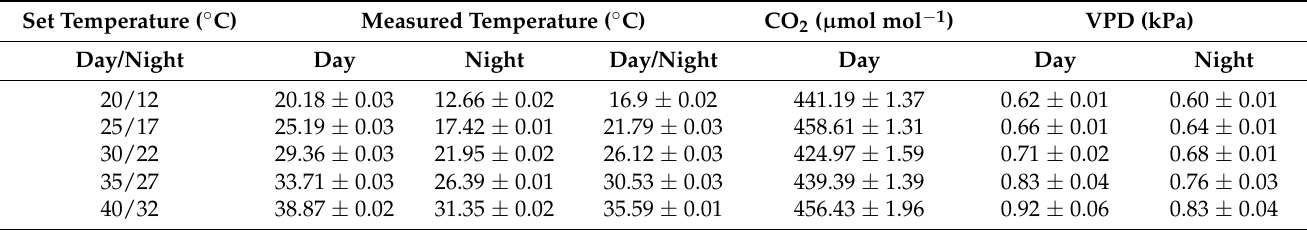
Table 1. Environmental parameters recorded during the experimental period: average day, night, and day/night temperatures, average day chamber CO 2 concentration, and average day/night vapor pressure deficit (VPD) during the experimental period of 28 days.